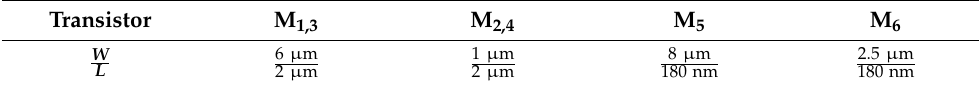
Table 3. The aspect of the ratio of the proposed amplifier transistors.